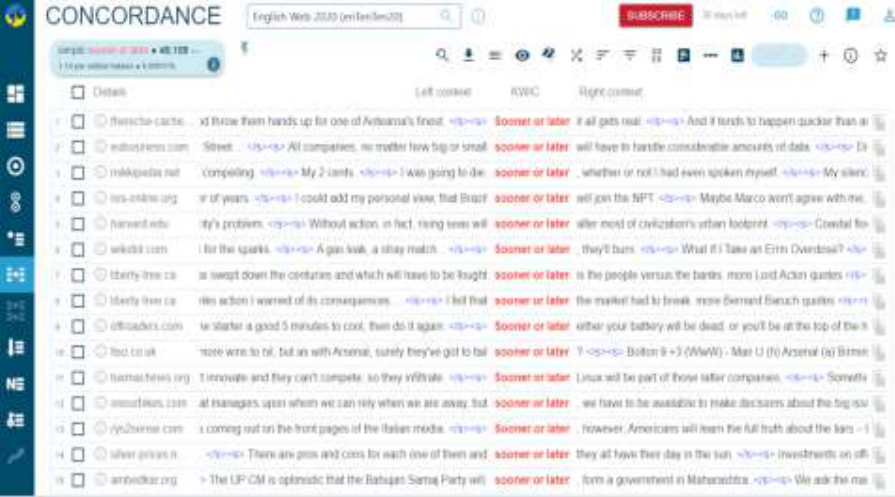
Table 3. CONCORDANCE entry of the phrase “ sooner or later